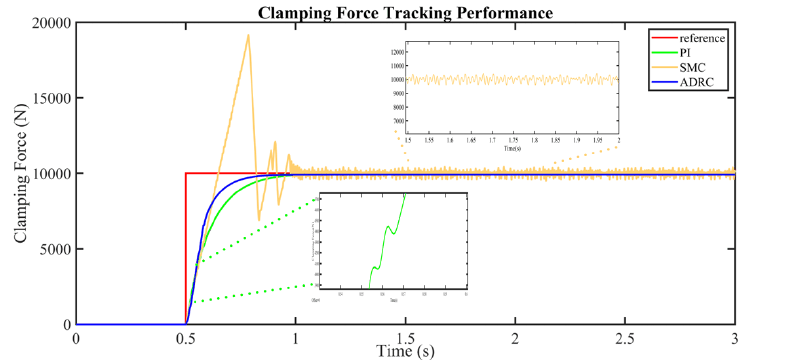
Figure 10. The clamping force tracking performance at the maximum target value.